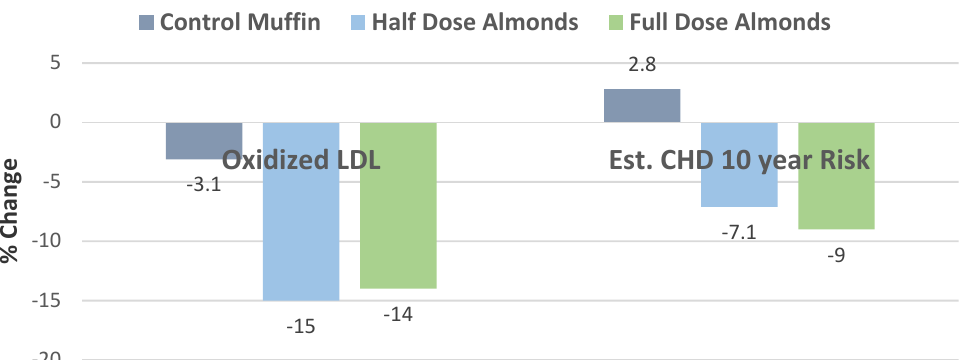
Figure 30. Dose–response effects of almond NCEP Step 2 diets from baseline to 4 weeks: (1) Both doses of almonds significantly reduced LDL oxidation compared to baseline and muffin control ( p < 0.001). (2) The full almond dose significantly reduced estimated 10-year CHD risk ( p ≤ 0.029) [51].